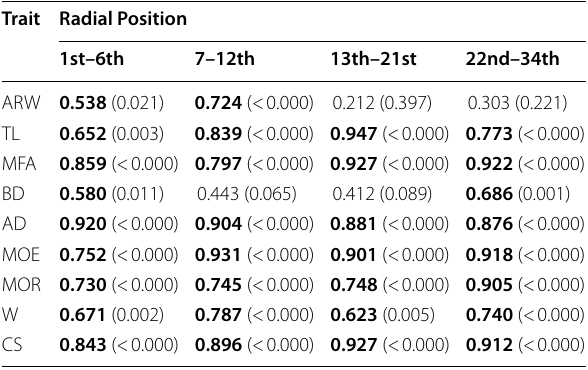
Number of sample trees